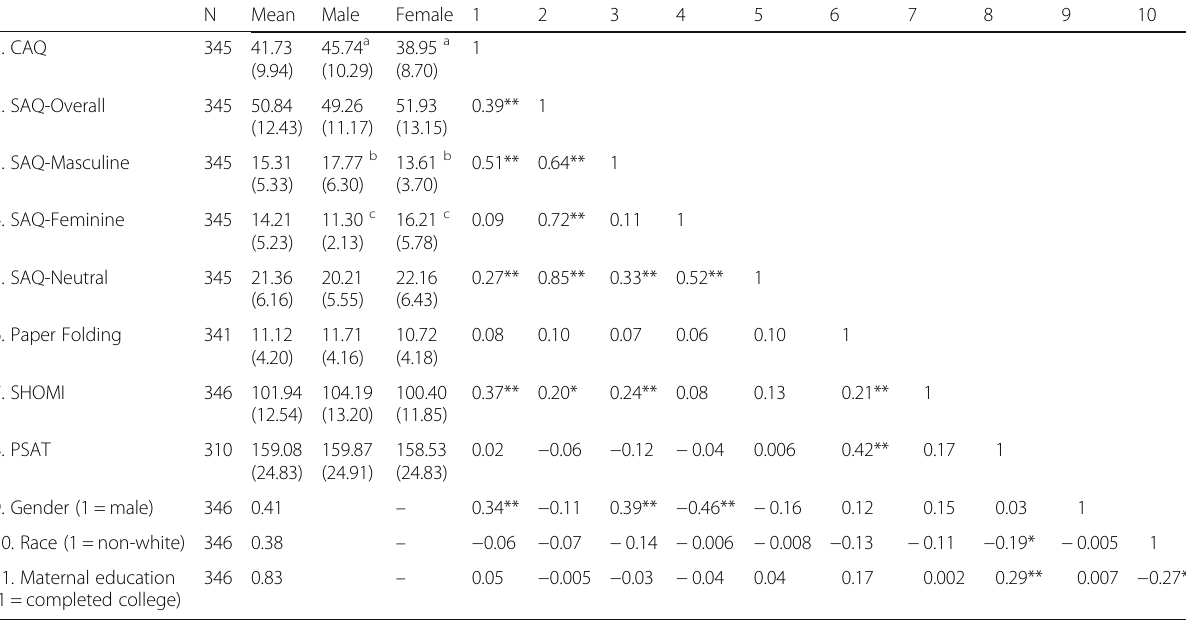
Table 1 Bivariate correlations for spatial activities, spatial thinking measures, and covariates